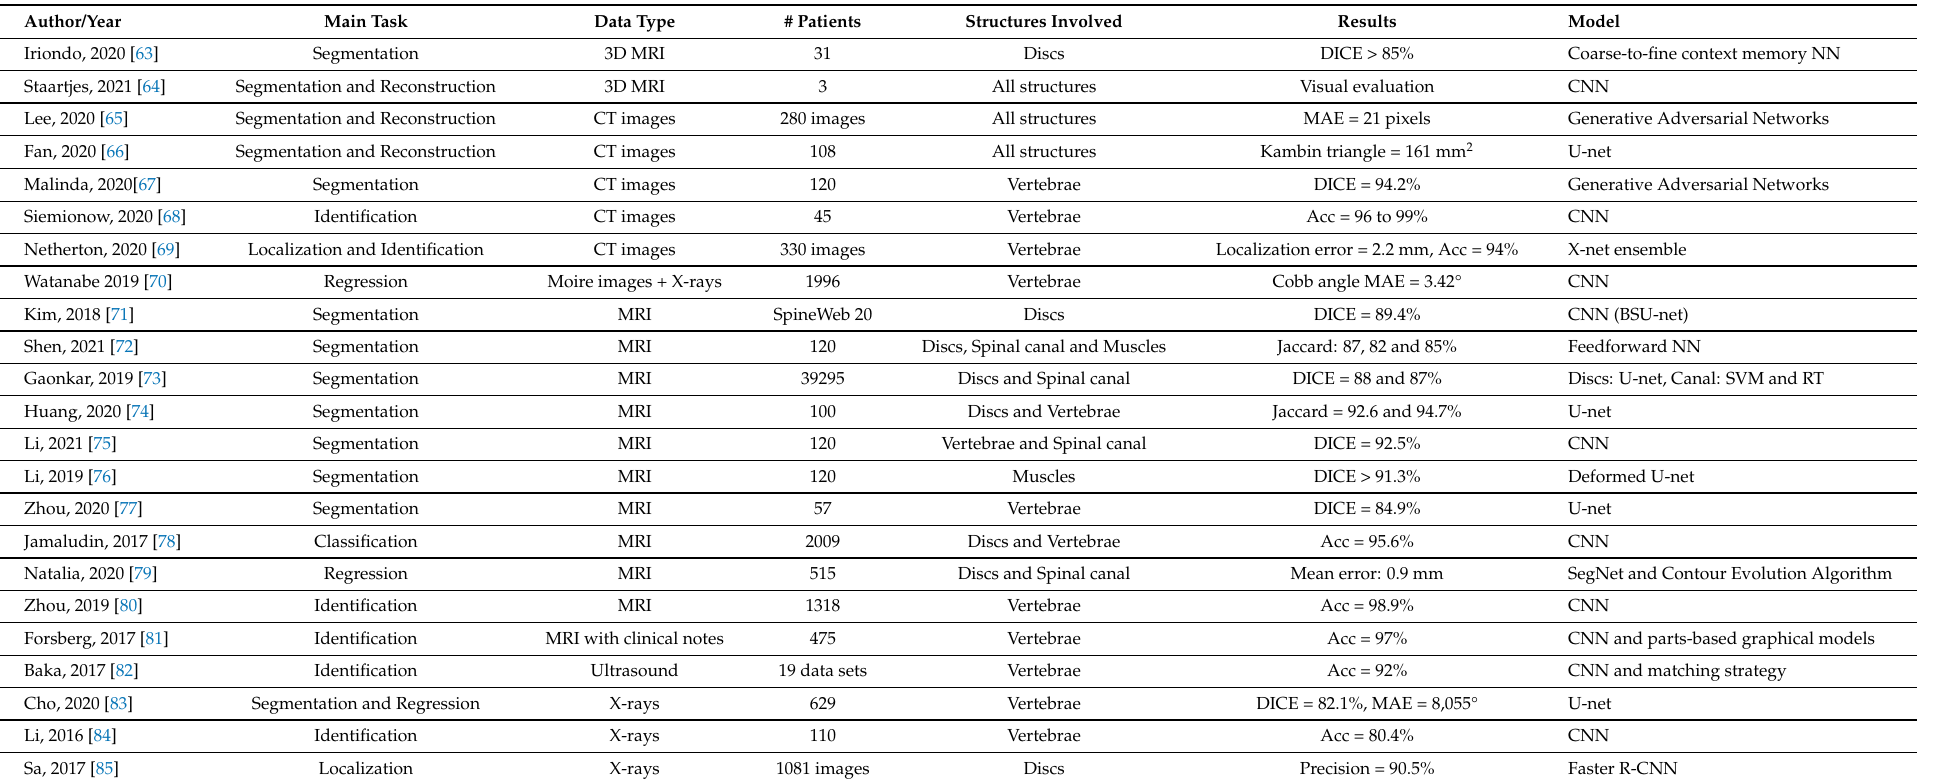
Table 3. Segmentation—Deep Learning. For each work, the main task is reported, whether it concerns only the segmentation of lumbar components, or if it aims to localize specific parts (e.g., the center of mass) of the components, or if it aims to identify each component (e.g., differentiating vertebrae between each other). If more structures are investigated, the correspondent results are reported following the same order by which structures are presented in the “Structures involved” column. Abbreviations are used for Magnetic